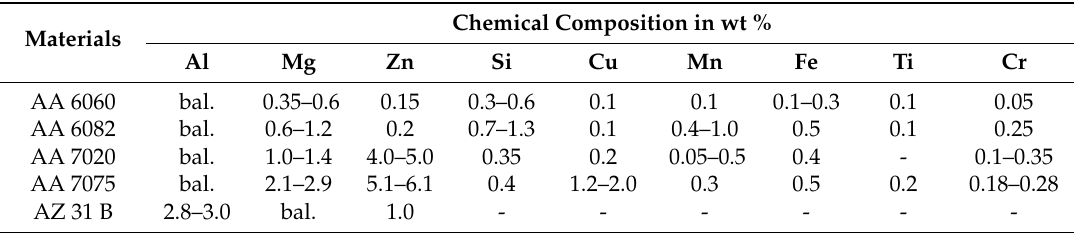
Table 1. Chemical composition of the base materials according to manufacturer’s specifications